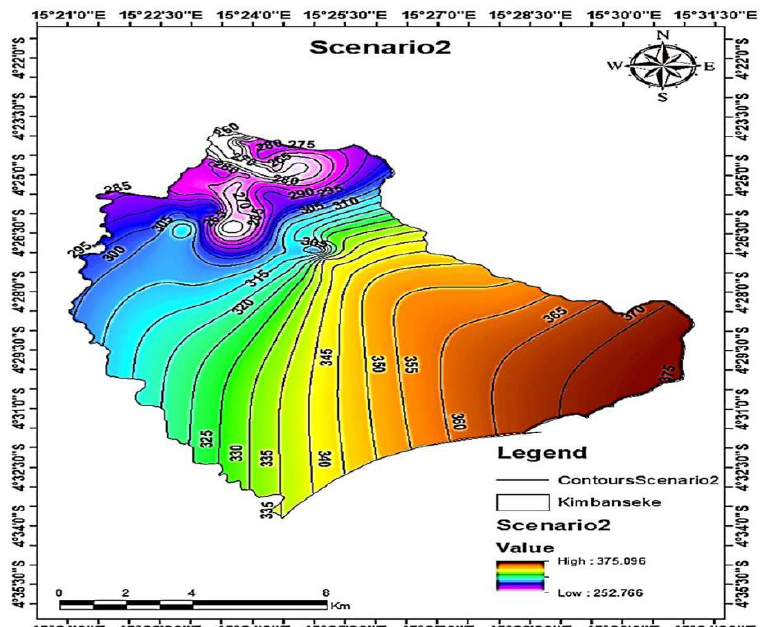
Figure 20. Scenario 2.